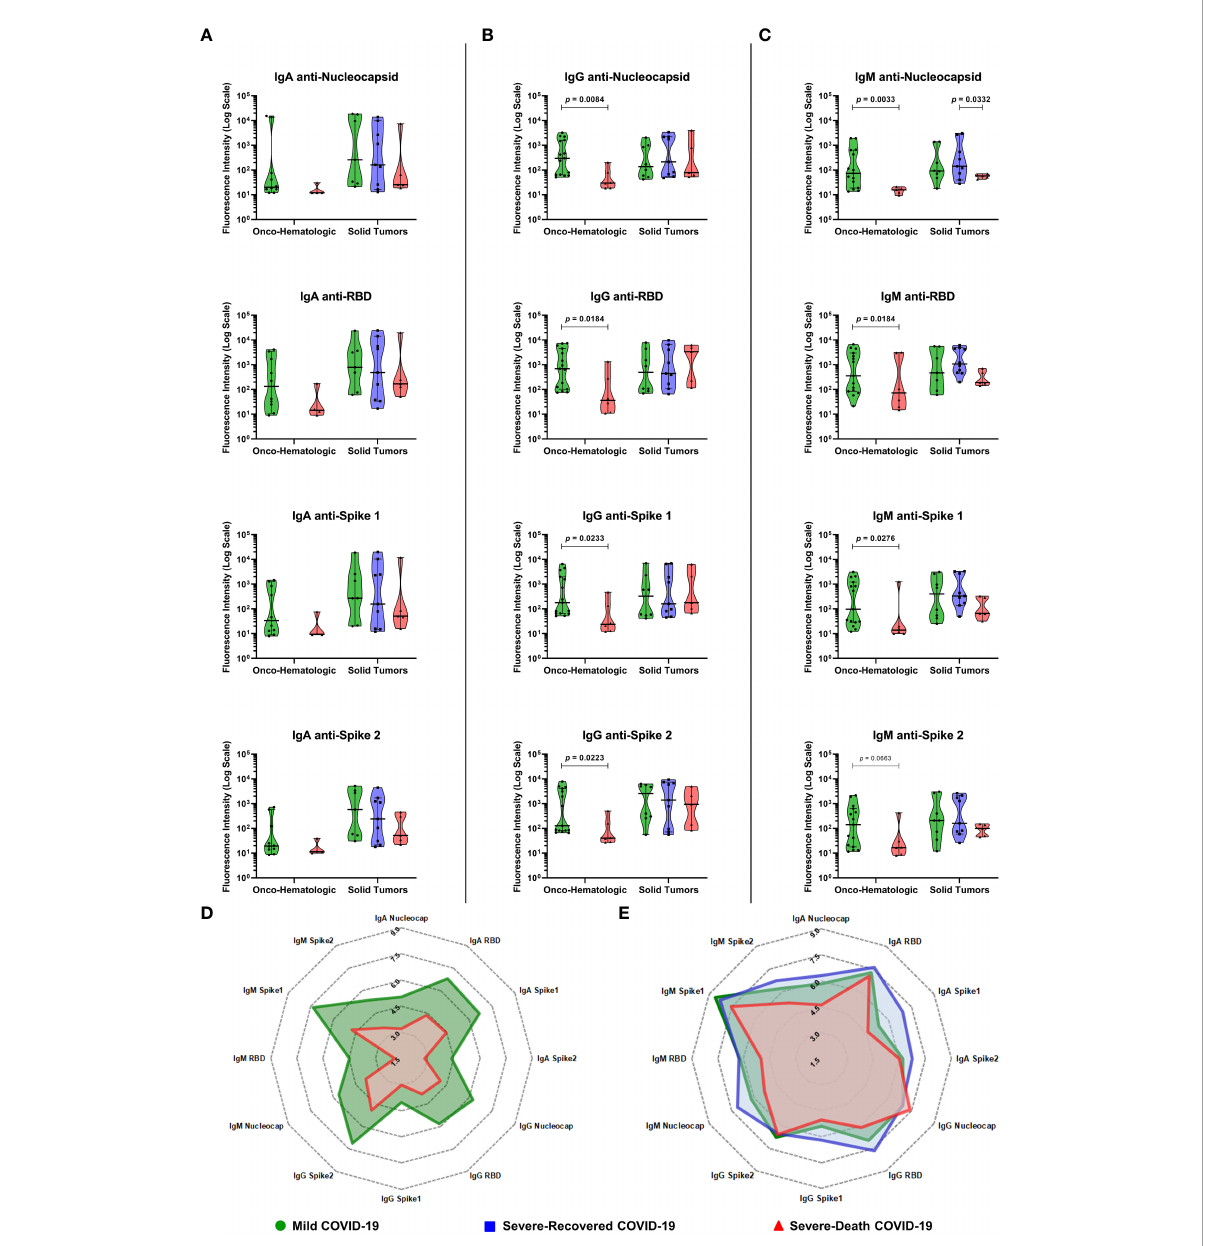
FIGURE 4 COVID-19 positive patients with hematologic malignancies that develop severe disease culminating in death display decreased IgG anti-SARS- CoV-2 antibodies before disease progression. Blood samples were collected within two days (median; 1 – 4 CI) of the positive SARS-CoV-2 diagnostic and analyzed for Immunoglobulins IgA (A) , IgG (B) and IgM (C) anti-SARS-CoV-2 proteins as described in Materials and Methods. Radar charts for Onco-hematologic (D) or Solid Tumors (E) patients show the mean values for each factor after fl uorescence intensity data was normalized by Ln(x+1). Groups were de fi ned based on disease severity, as Mild (green), Severe-Recovered (blue), or Severe-Death (red), as described. Data is presented as median plus 95% con fi dence intervals and was analyzed with Kruskal-Wallis adjusted for multiple comparisons followed by Dunn ’ s post-hoc test or Mann-Whitney test. All exact p -values below 0.1 are shown. Nucleocapsid, RBD, Spike 1 and Spike 2 labels refers to IgG antibodies anti-SARS-CoV-2 proteins. RBD, Receptor Binding Domain. N = 21 for Onco-hematologic and N = 22 for Solid Tumors group (IgG and IgM measurements) and N = 14 for Onco-hematologic and N = 21 for Solid Tumors group (IgA